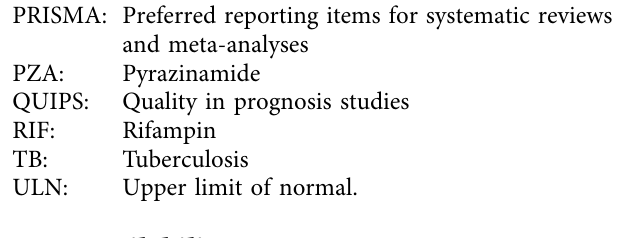
Supplemental Table 1: search strategies and results. Sup- plemental Table 2: general information of the included studies. Supplemental Table 3: summary of risk of bias as- sessment. Supplemental Table 4: the pooled incidence of ATLI in different countries. ( Supplementary Materials